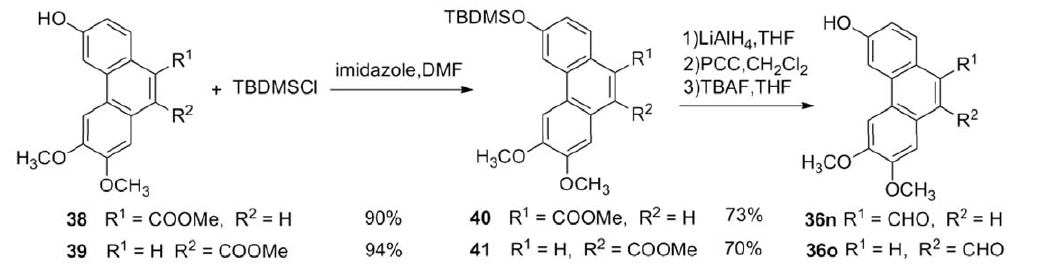
Figure 5. Synthesis of 2,3-dimethoxy6-hydroxyl-phenanthren-9-carboxaldehyde (36n) and 6,7-dimethoxy3-hydroxyl-phenanth- ren-9-carboxaldehyde (36o).